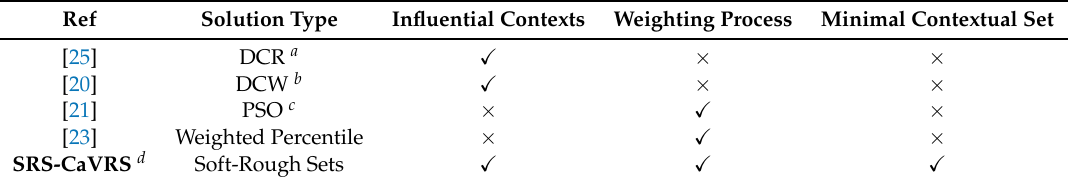
Table 1. Comparative analysis with the existing